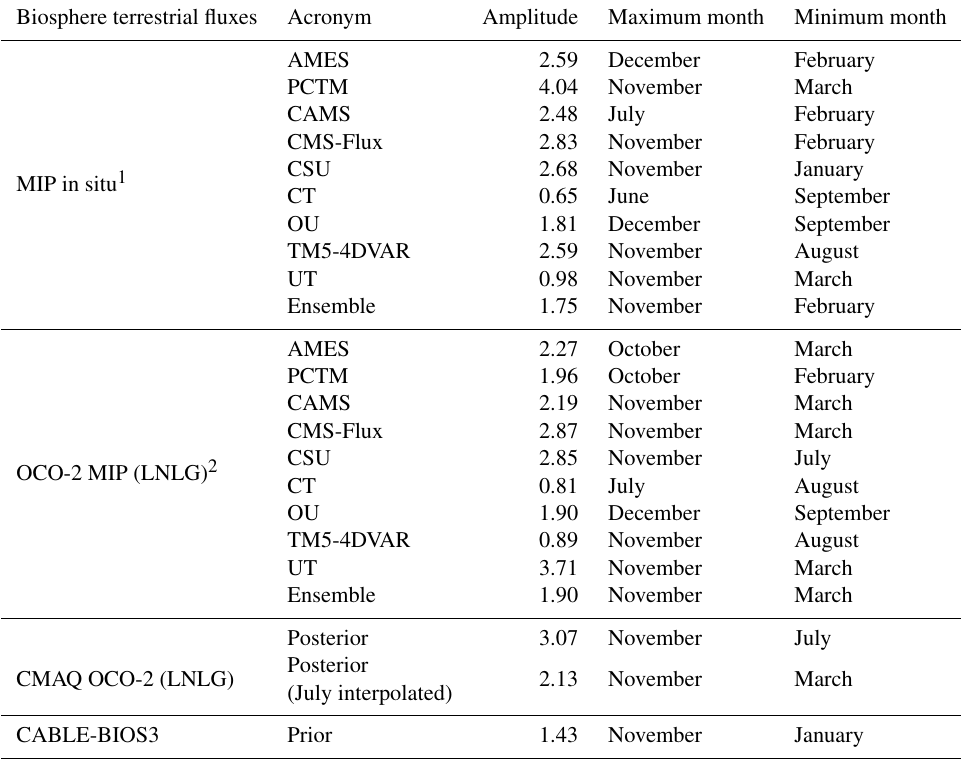
Table 4. Summary of the peak-to-peak amplitude of our posterior terrestrial fluxes, prior fluxes and terrestrial fluxes from nine different in situ and OCO-2 (LNLG) MIP global inversions. Units are PgCyr −